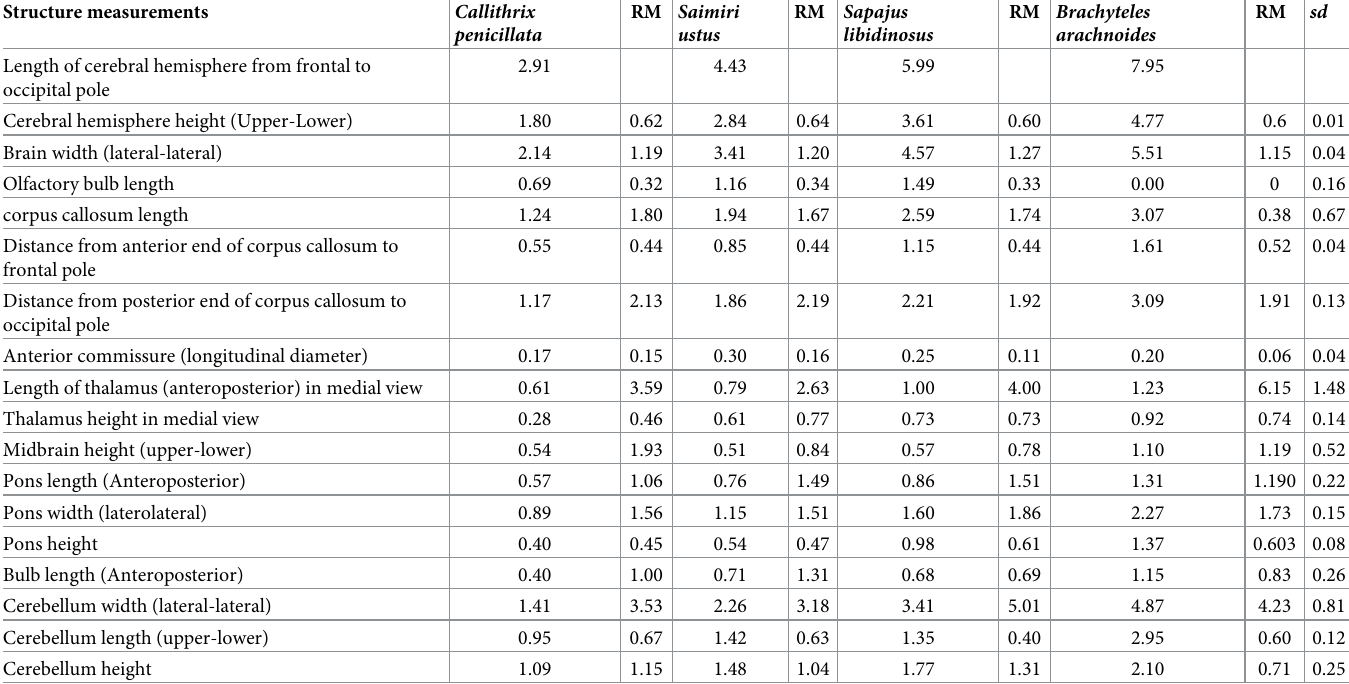
Table 2. Relative measurements of the sulci, gyri, encephalic trunk, and other structures as a function of brain length (length of the cerebral hemisphere from the frontal to the occipital pole for each species–RM (cm), or relative measure). Structure